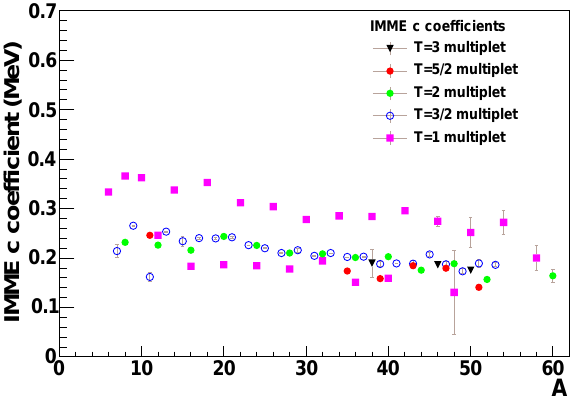
Figure 3. c coe ffi cients, in MeV, shown as a function of atomic mass number A extracted from a second degree IMME polynomial fit: a + bT z + cT 2 . This coe ffi cient is interpreted as being directly related to the tensor part of z the Coulomb force c = 3 E (2) C